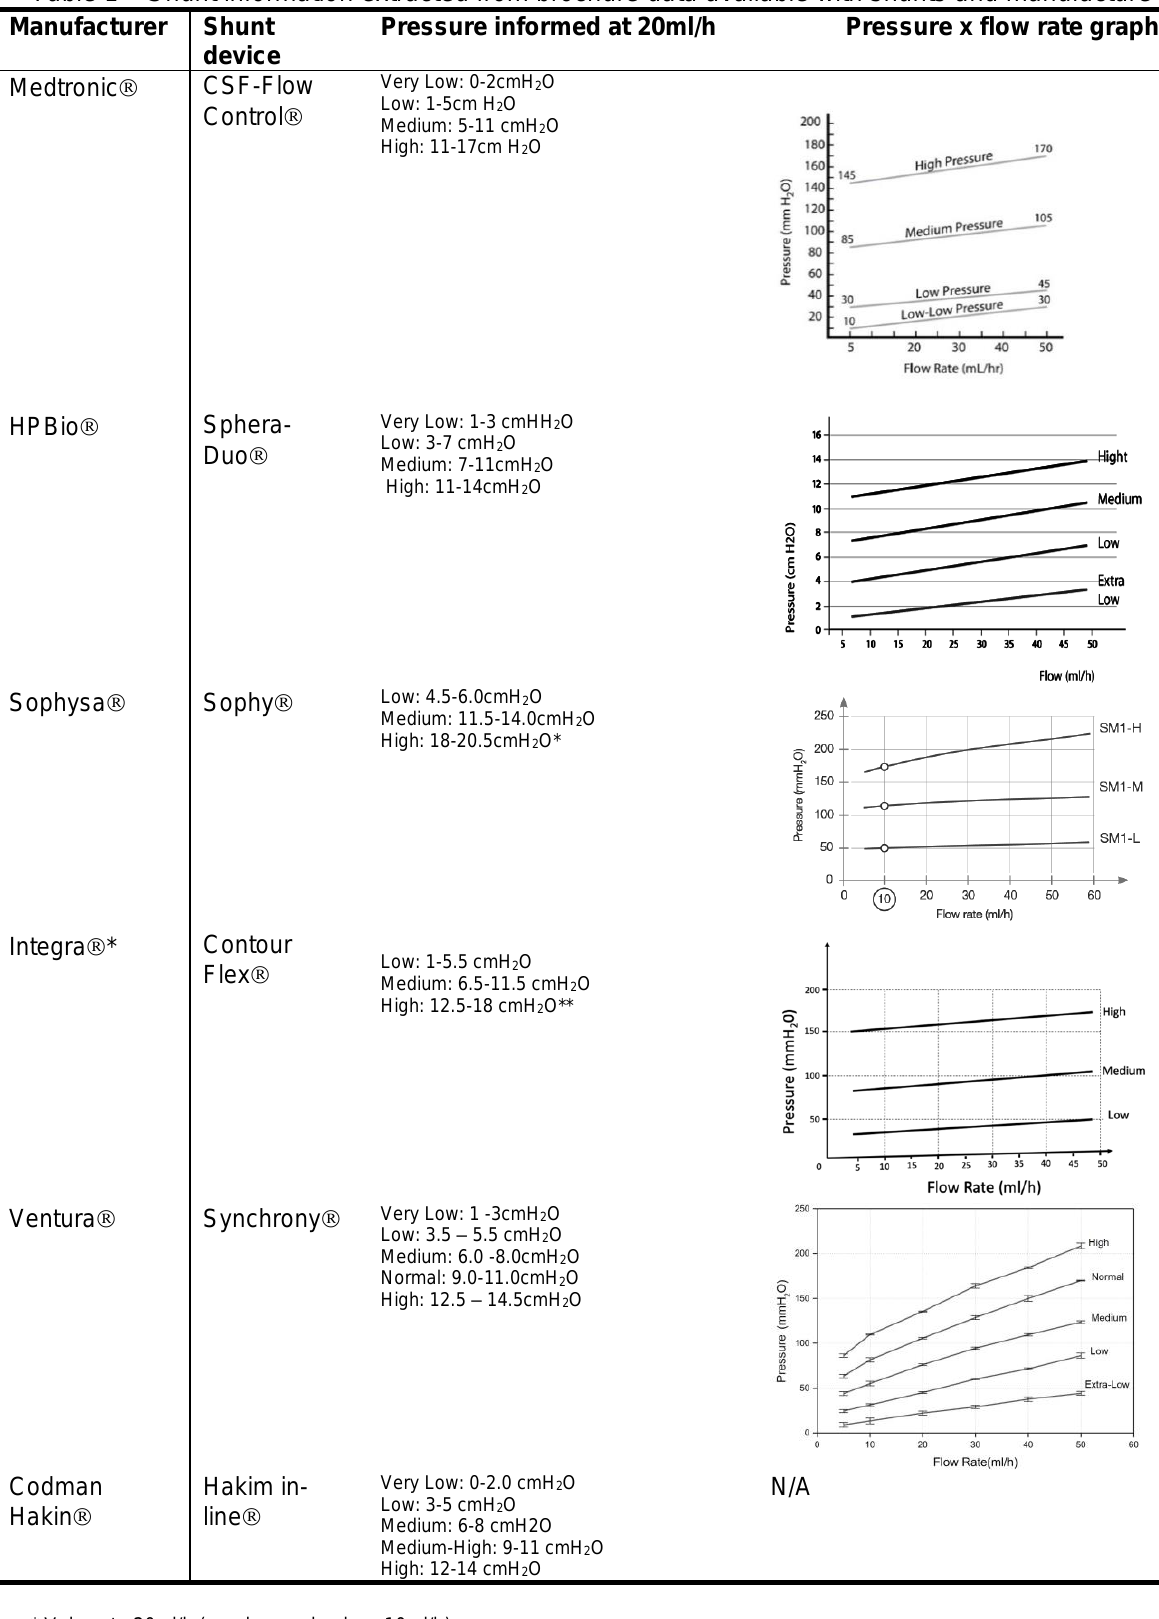
Table 1 – Shunt information extracted from brochure data available with shunts and manufacture website